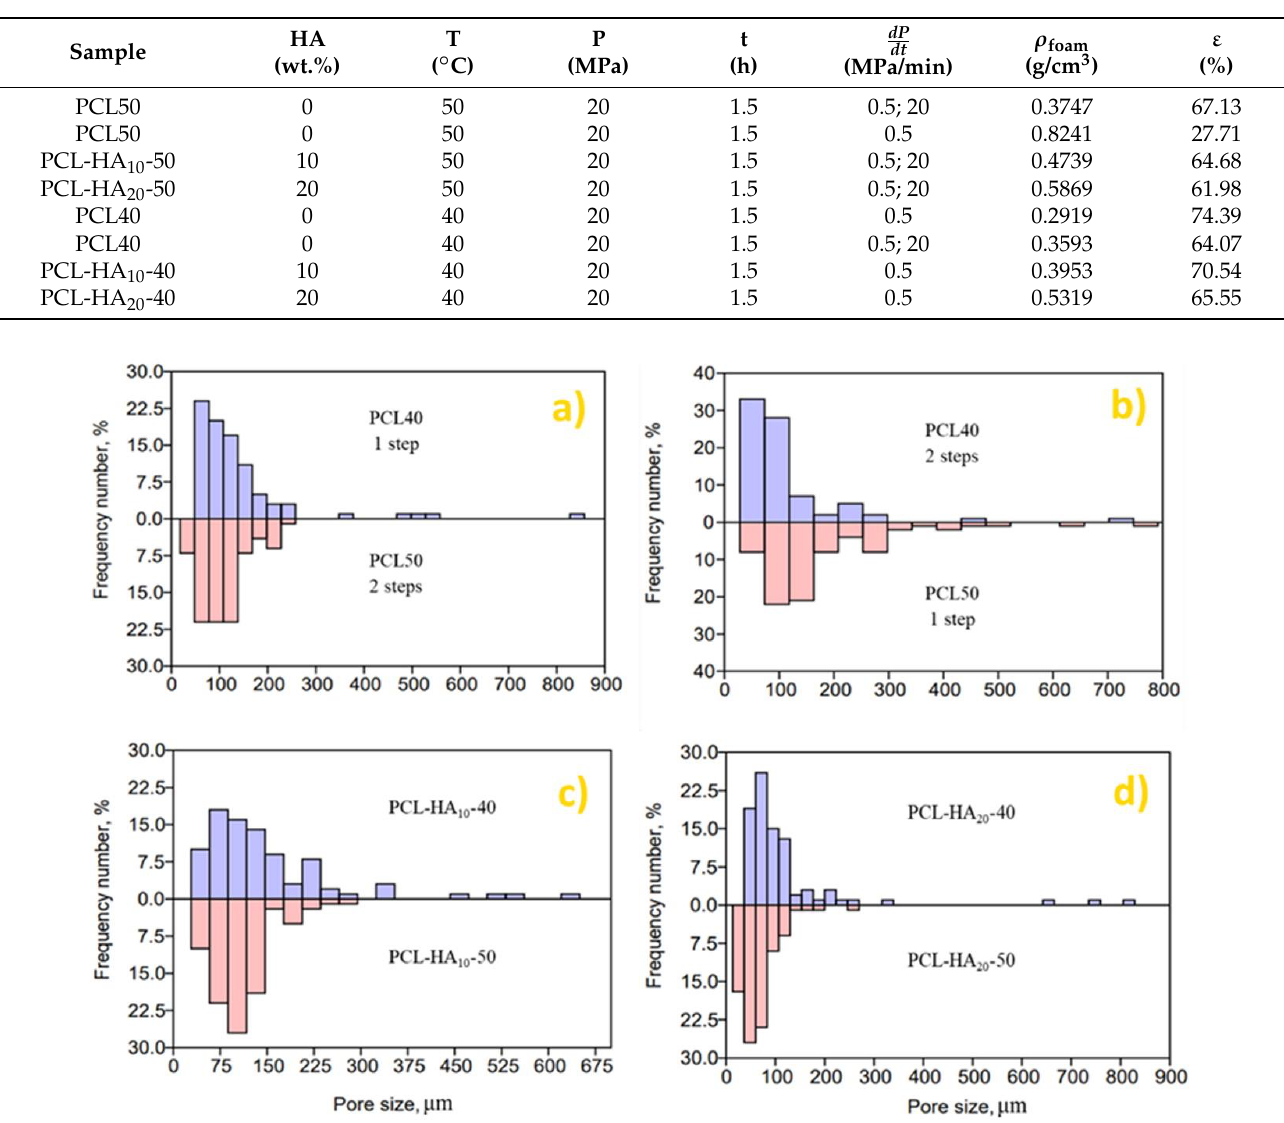
Table 1. Foam density and porosity of the neat and hydroxyapatite (HA) containing polycaprolactone (PCL) scaffolds obtained at different temperature and decompression rates.